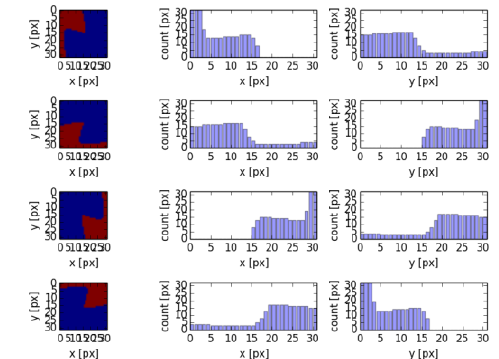
Figure 4. Rotation of the templates for each 90°, the procedure will pick the orientation in the first